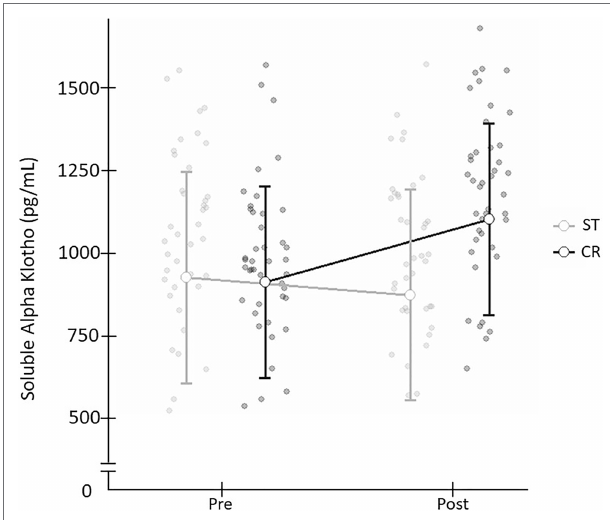
FIGURE 3 | Plasma S α KI levels determined before and after the exercise intervention in the CR and ST